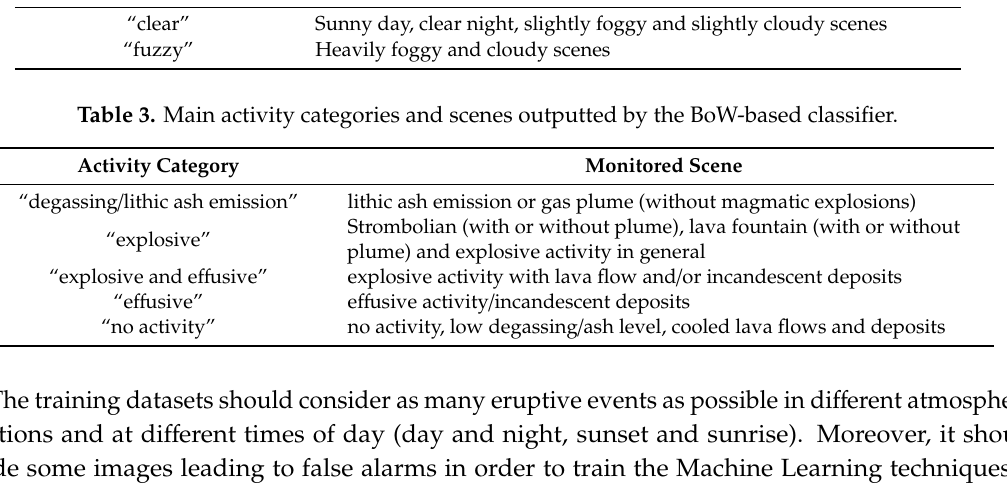
Table 2. Main activity categories and scenes outputted by the DT classifier.